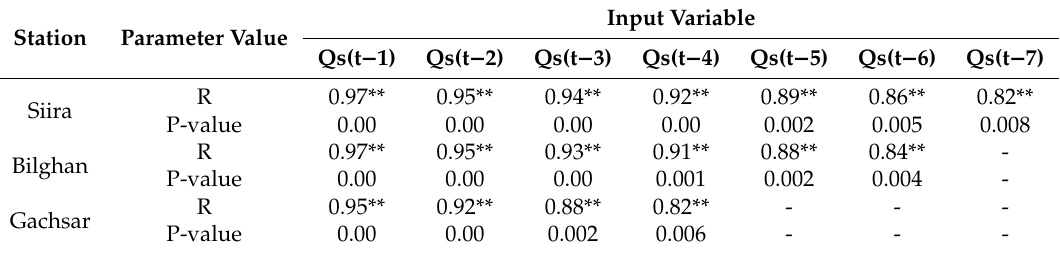
Table 2. Values of the correlation coe ffi cient between the daily streamflow and the individual input